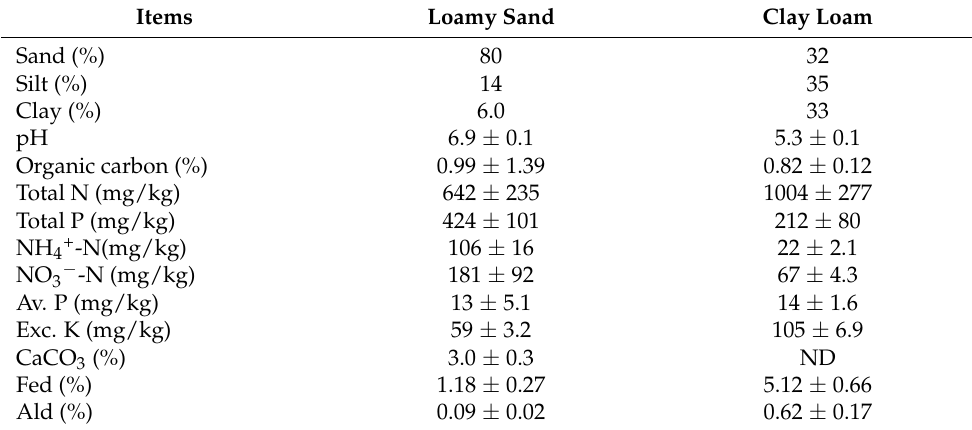
Table 1. Basic properties of the experiment soil.